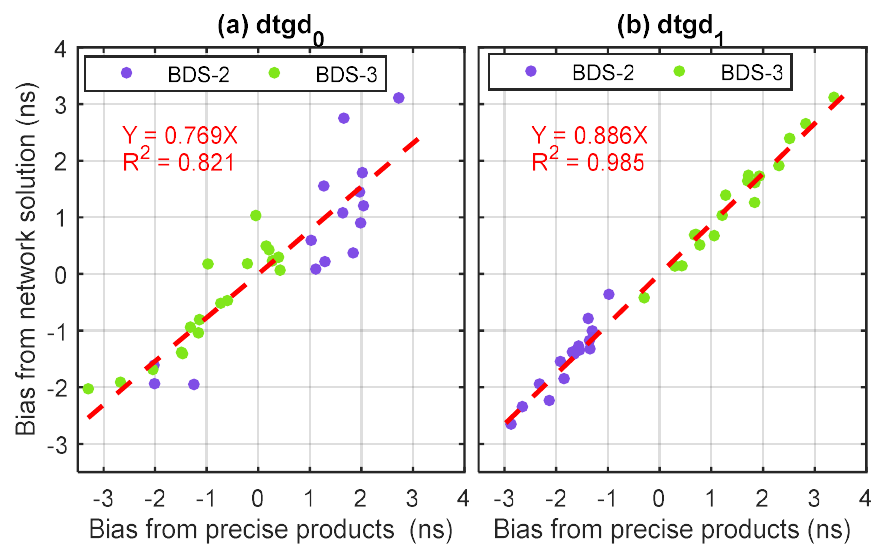
Figure 6. Relationship between the TGD bias from precise products and the network solution. The red dashed lines plot their relationship after linear fitting and R 2 is the correlation coefficient. dtgd 0 means the TGD bias at B3I frequency and dtgd 1 is the residual TGD bias of TGD 1 . The average difference for all satellites was removed.